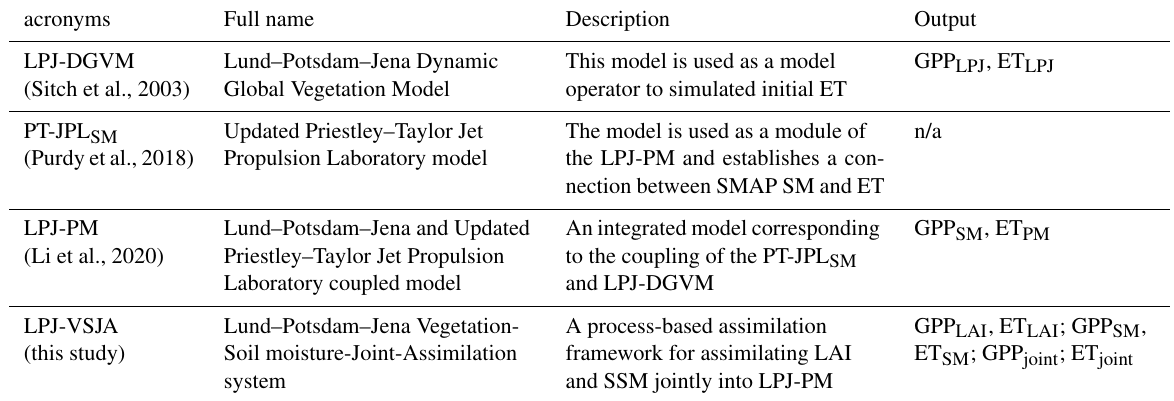
Table 1. Description of the models and outputs in this study. “n/a” stands for “not applicable”.